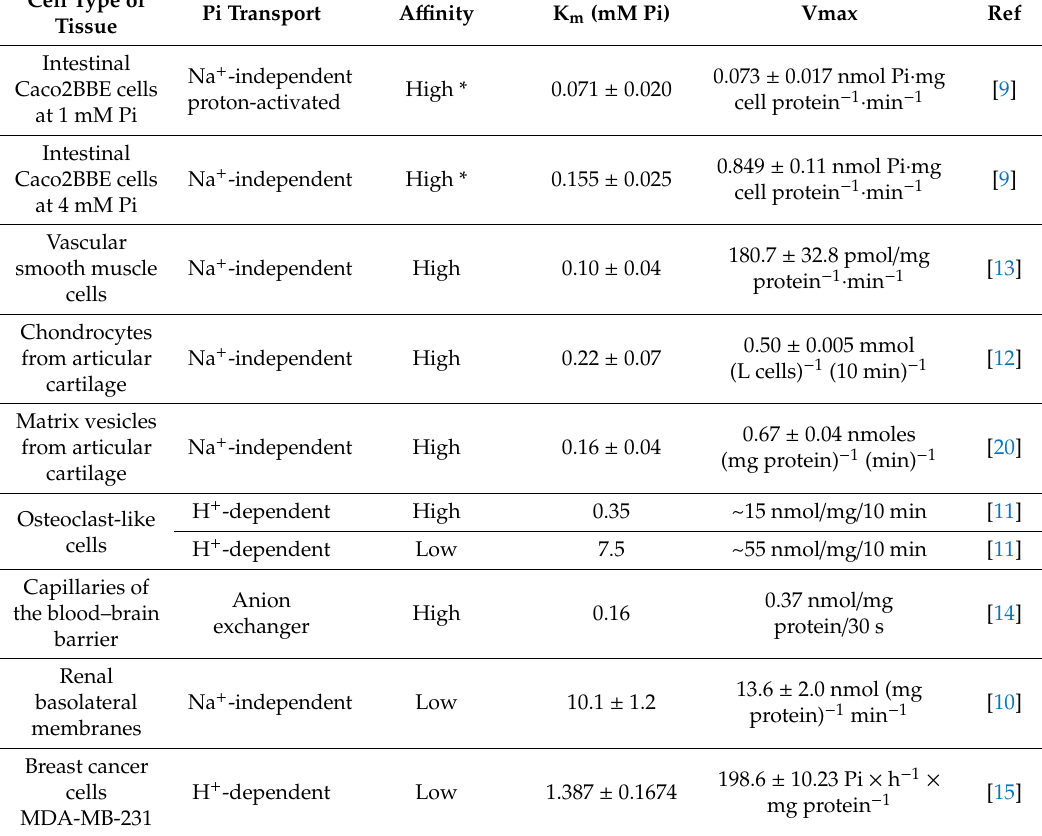
Table 1. Kinetic parameters of sodium-independent Pi transport in mammalian